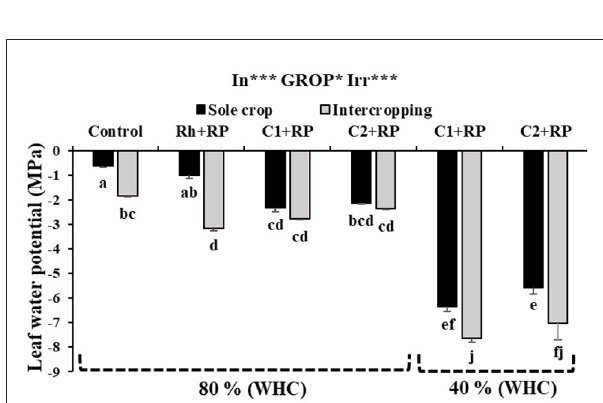
FIGURE4 Leaf water potential in faba bean grown as a sole crop or intercropped with wheat under water sufficiency and P limitation (80% WHC, RP) vs. combined water deficit and P limitation (40% WHC, RP) and inoculated with two rhizobacterial consortia (C1